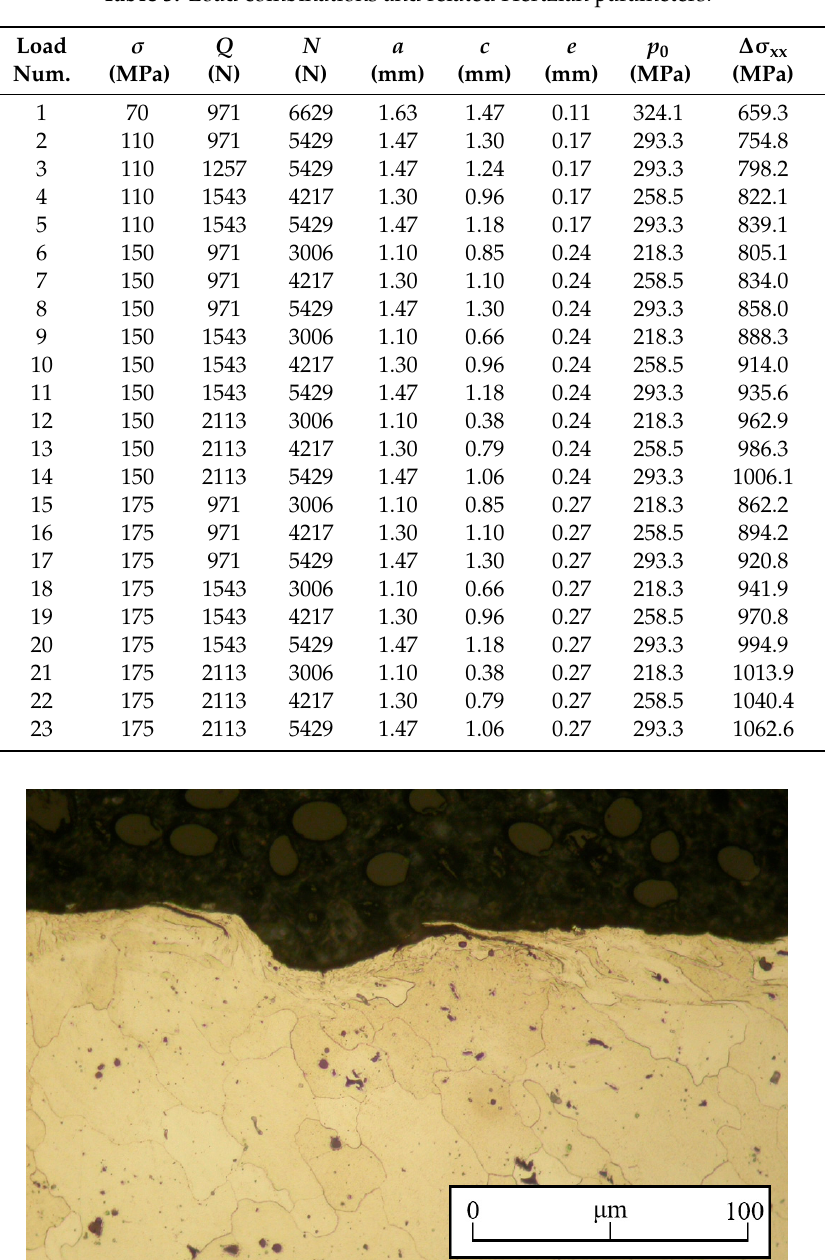
Figure 3. An optical microscope image of the cross section in a shot-peened dog–bone test specimen.